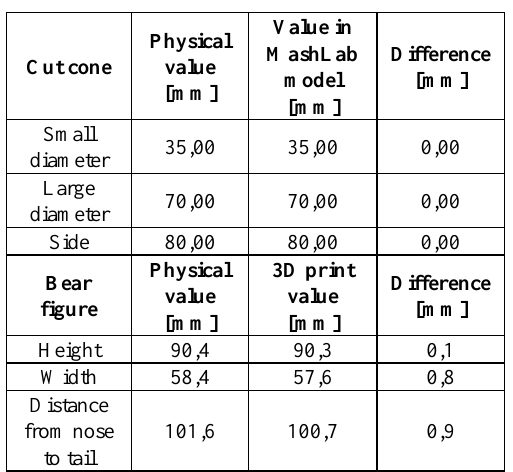
Table 2. Comparison of results of the objects